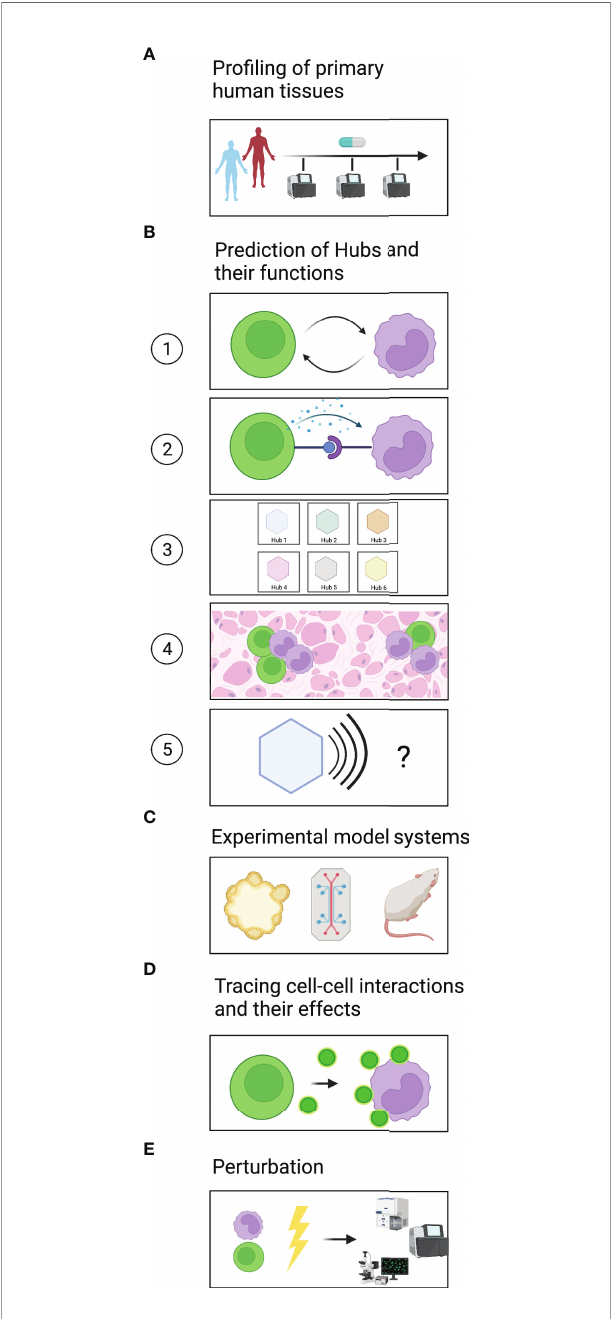
FIGURE 2 | A roadmap to identify and mechanistically dissect multicellular hubs. (A) Pro fi ling of healthy and diseased tissues across different timepoints using high-plex methods to discover multicellular hubs in primary human tissues. (B) Based on the pro fi ling data, prediction of (1) which cells interact and (2) which signals they use. (3) Grouping of cell states into strongly connected modules to generate a dictionary of multicellular hubs. (4) Spatial map of hubs and their components in tissues. (5) Prediction of the hubs ’ modular function. (C) Modeling of multicellular hubs in primary human ex vivo systems or animal models. (D) Experimental tracing of cell-cell communication. (E) Experimental perturbation to gain mechanistic